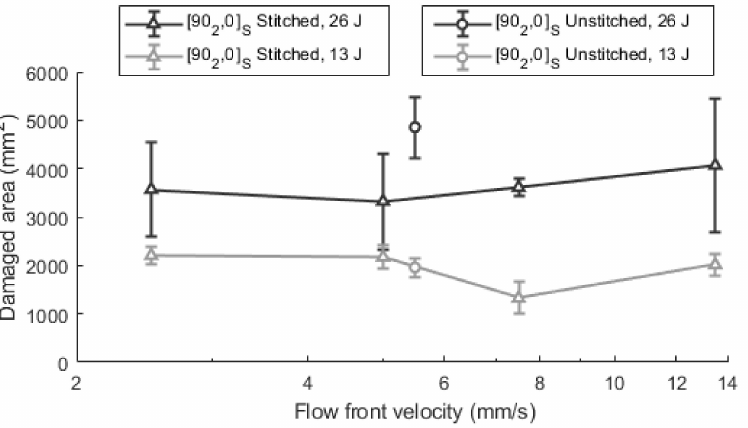
Figure 10. Damaged area for stitched and unstitched [90 2 , 0] S laminates at 13 J and 26